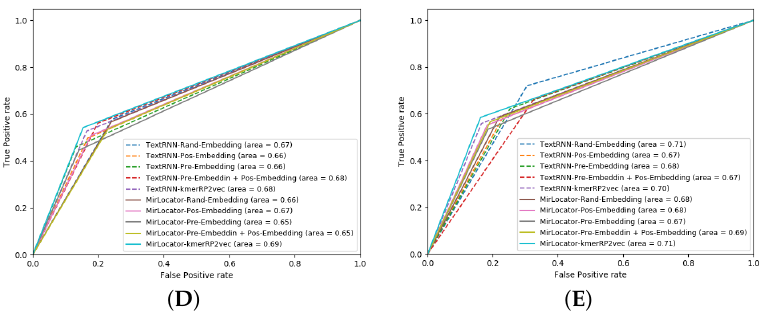
Figure 7. Area Under the Receiver Operating Characteristic (AUROC) graphs of the proposed MirLocPredictor and TextRNN using 5 different representation schemes over 5 folds: ( A ) fold 1, ( B ) fold 2, ( C ) fold 3, ( D ) fold 4, and ( E ) fold 5.